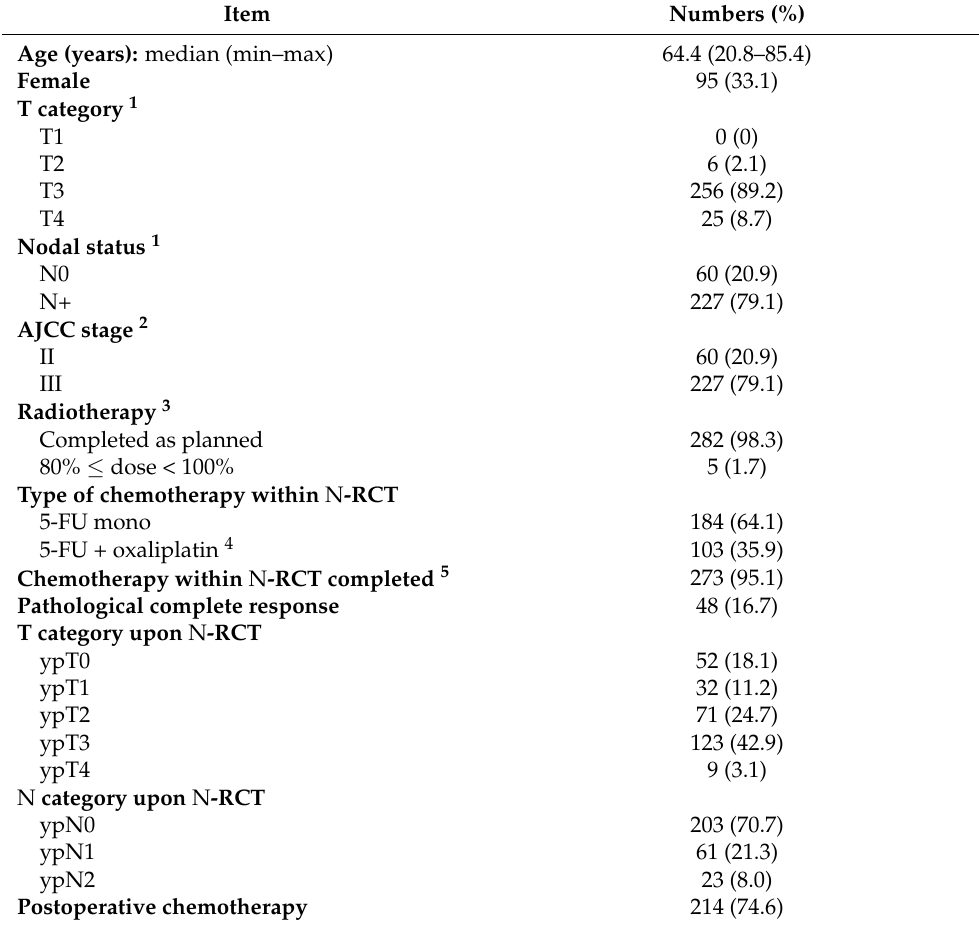
Table 2. Baseline patient, disease, and treatment characteristics (based on the 287 eligible patients). If not otherwise stated, per item the respective numbers with percentage in brackets are